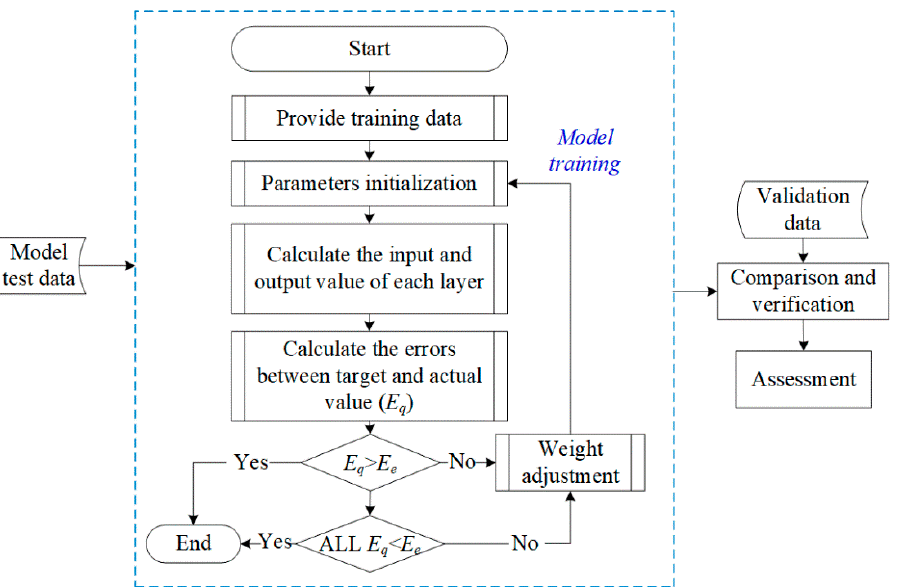
Figure 5. Flow chart of BPANN model structure for modeling MRE isolator.